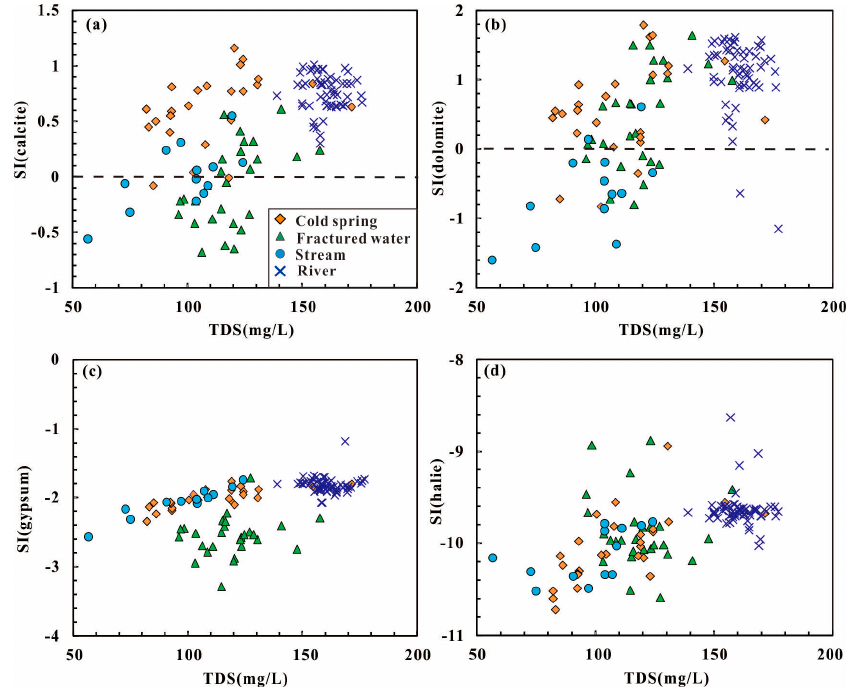
Figure 8. Saturation index (SI) versus total dissolved solids (TDS) (mg/L) diagrams. ( a ) SI (calcite); ( b ) SI (dolomite); ( c ) SI (gypsum), and ( d ) SI (halite). ( b ) SI (dolomite); ( c ) SI (gypsum), and ( d ) SI